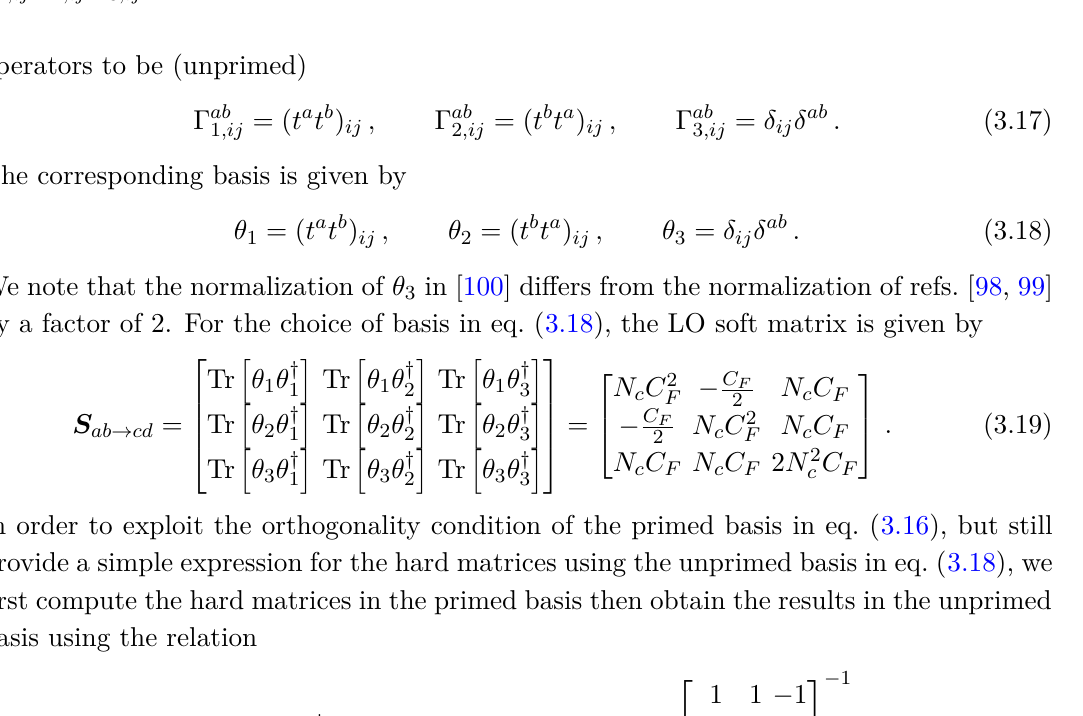
Table 2 . The choice of basis for each of two quark two gluon subprocesses. Three operators Γ ab , Γ ab , Γ ab are required to span the color space for each 1 ,ij 2 ,ij 3 ,ij